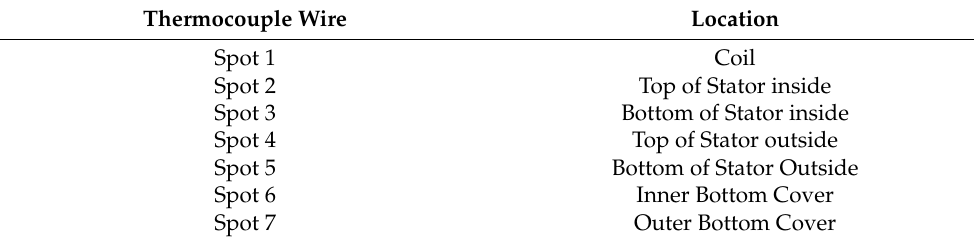
Figure 9. Thermocouple wire attachment location. Table 4. Main parameter of the